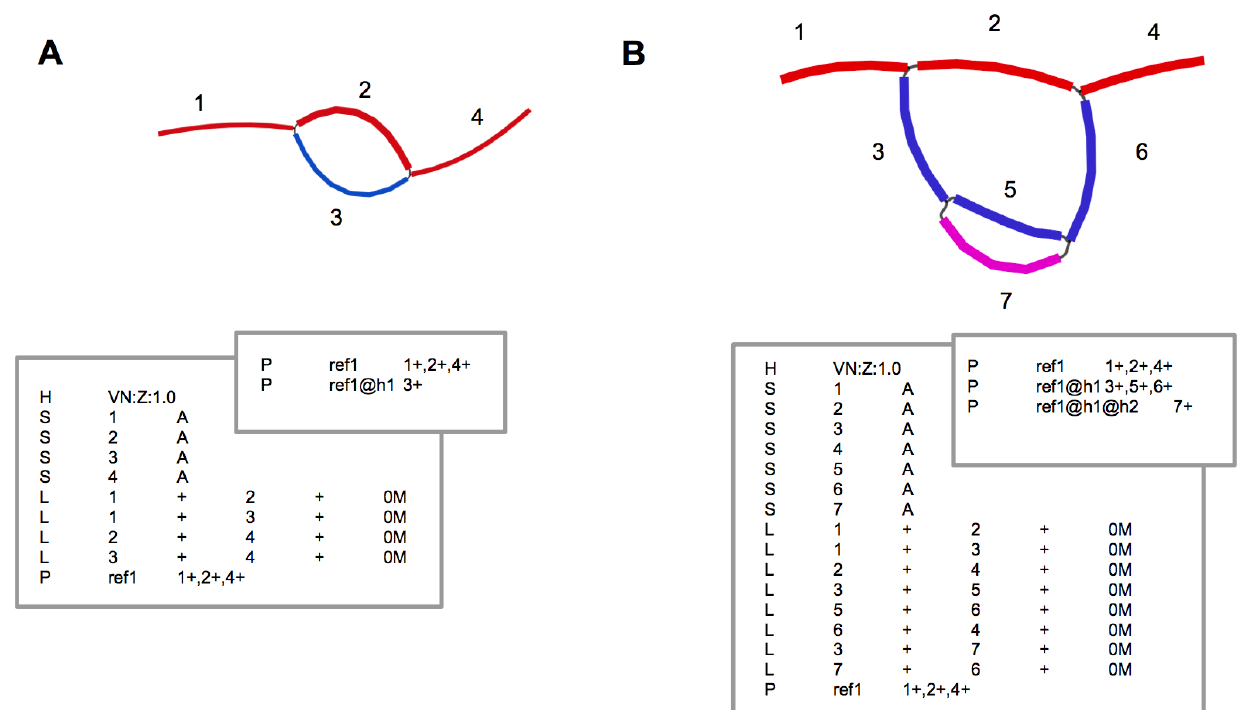
Figure 4. Adding additional haplotype from A to B . The existing sequence and coordinates remain the same even though the nodes and edges